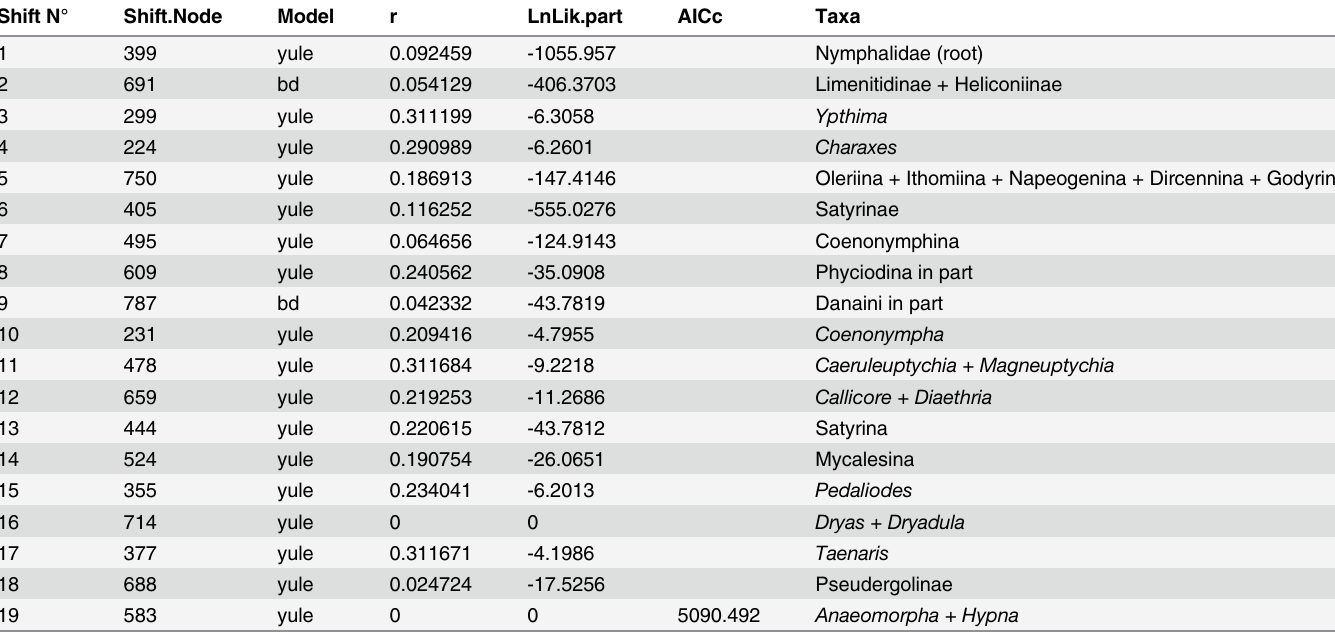
Table 1. Significant net diversification rate shifts found in the MEDUSA analysis of the Nymphalid maximum clade credibility tree. Shift N°